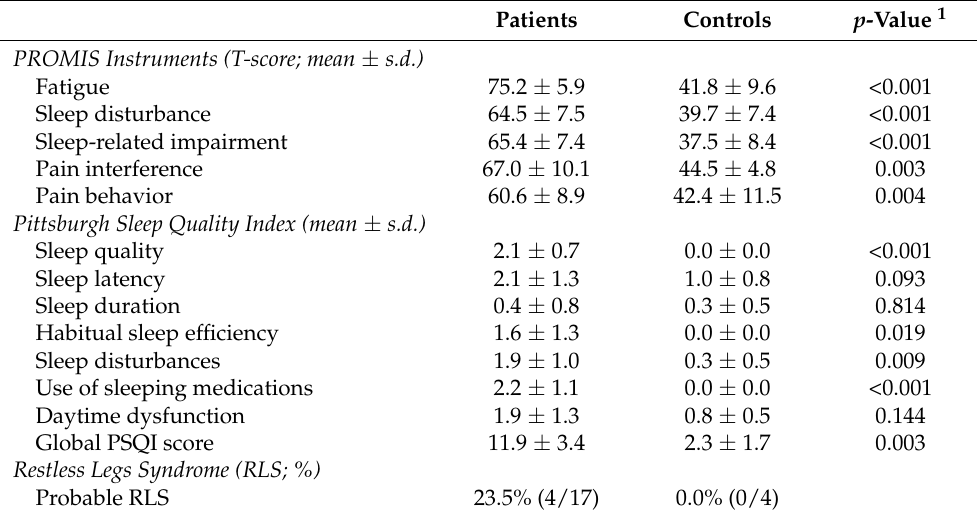
Table 2. Comparison of patient-reported health status between severe ME/CFS patients and healthy